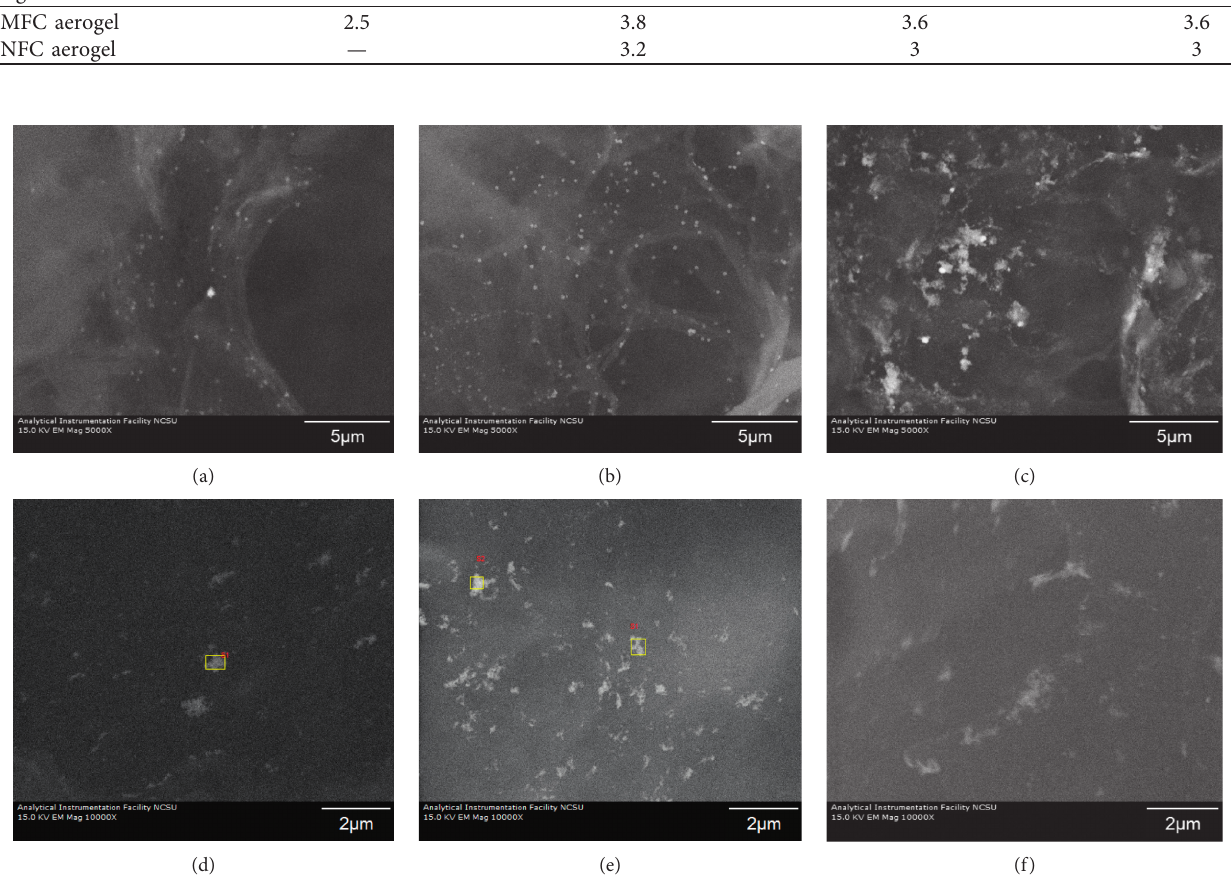
Figure 2: Ag-NPs in MFC/CH aerogel: (a) 10%CH, (b) 20%CH, and (c) 30%CH; NFC/CH aerogel: (d) 10%CH, (e) 20% CH, and (f) 30% CH.